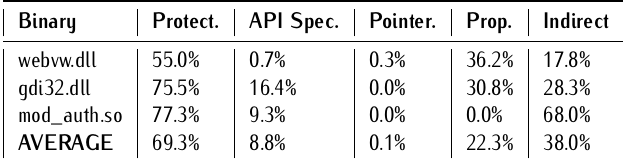
Table 3. Coverage of SWRRs produced by RVM. Table 4. Performance of RVM: all execution time is measured in